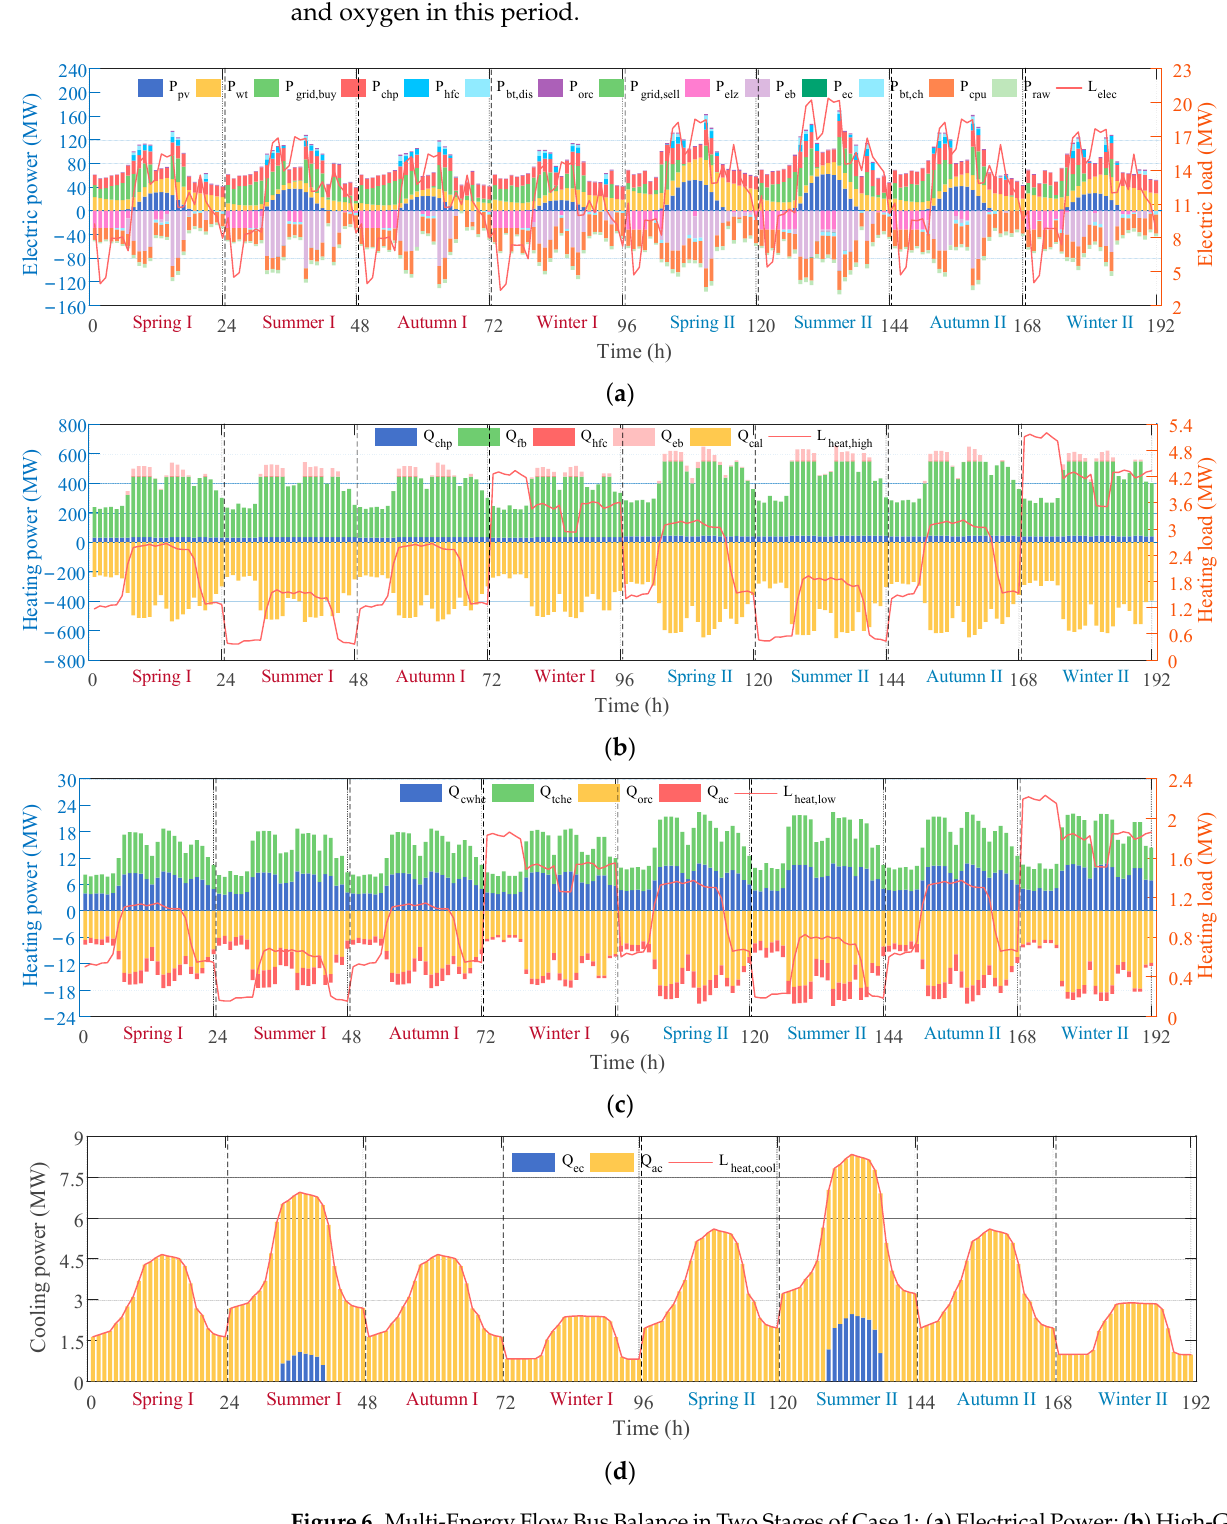
Figure 6. Multi-Energy Flow Bus Balance in Two Stages of Case 1: ( a ) Electrical Power; ( b ) High-Grade Heat Demand; ( c ) Low-Grade Heat Demand; ( d ) Cooling Energy.